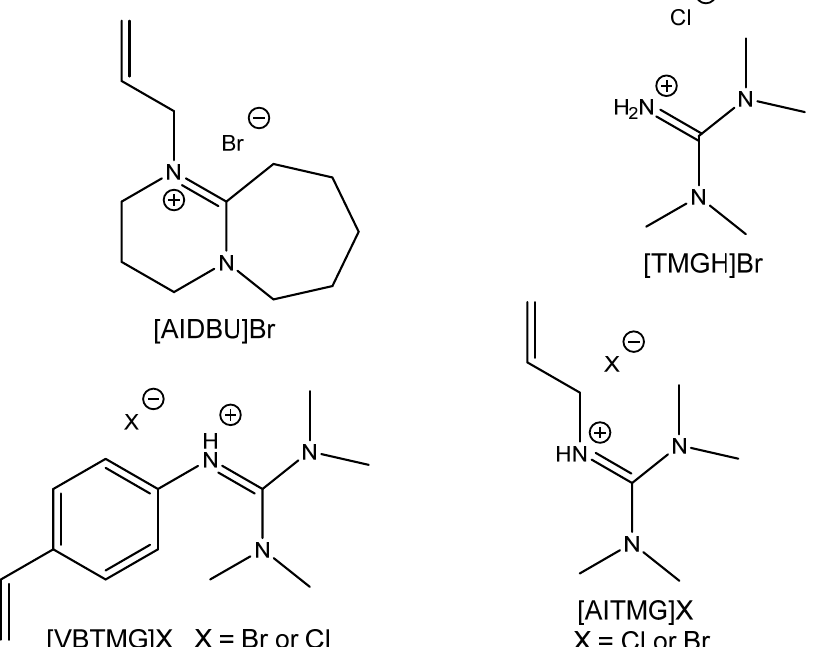
Figure 18. Structures of functionalized ILs tested as highly active CO 2 cycloaddition catalysts [104].